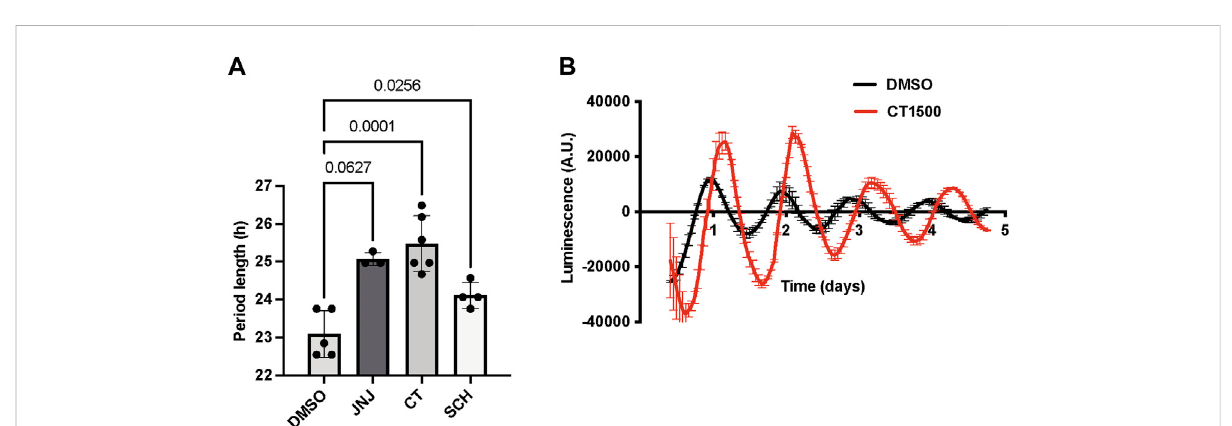
FIGURE 1 Effect of CT1500 on period length of SCN. (A) SCN isolated from adult Per2::Luc mice were cultured for 3 days after which the indicated drugs were added to the bath at a fi nal concentration of 3 µM (n as indicated in fi gure) and bioluminescence recorded for another 5 days. Period length after drug addition reported and data analysed by one-way ANOVA ( p = 0.001, n too small to determine normality). p -values from multiple comparisons with Tukey ’ s multiple comparisons test reported in the fi gure. (B) Representative trace from a slice treated with CT1500 shown. Data presented as each replicate and mean and S.D.